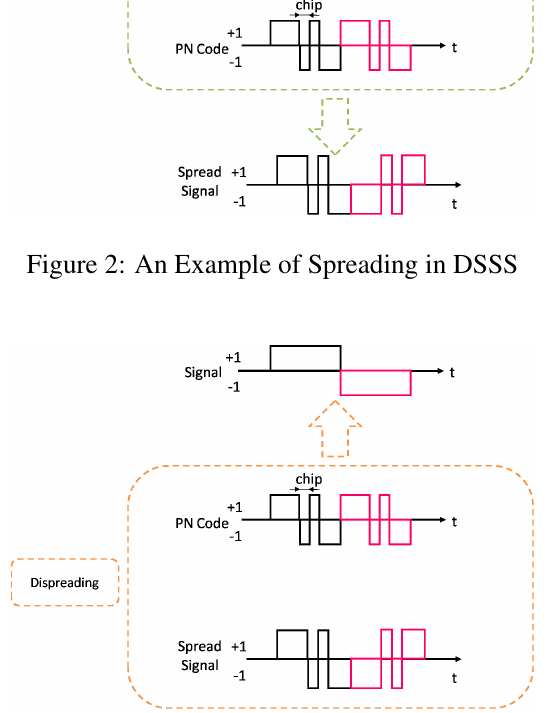
Figure 3: An Example of Despreading in